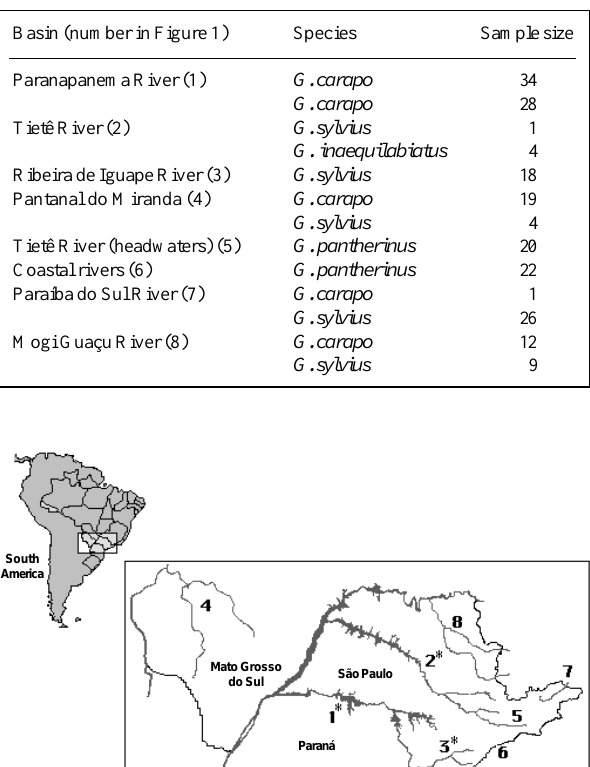
Table I - Samples of Gymnotus species analyzed.